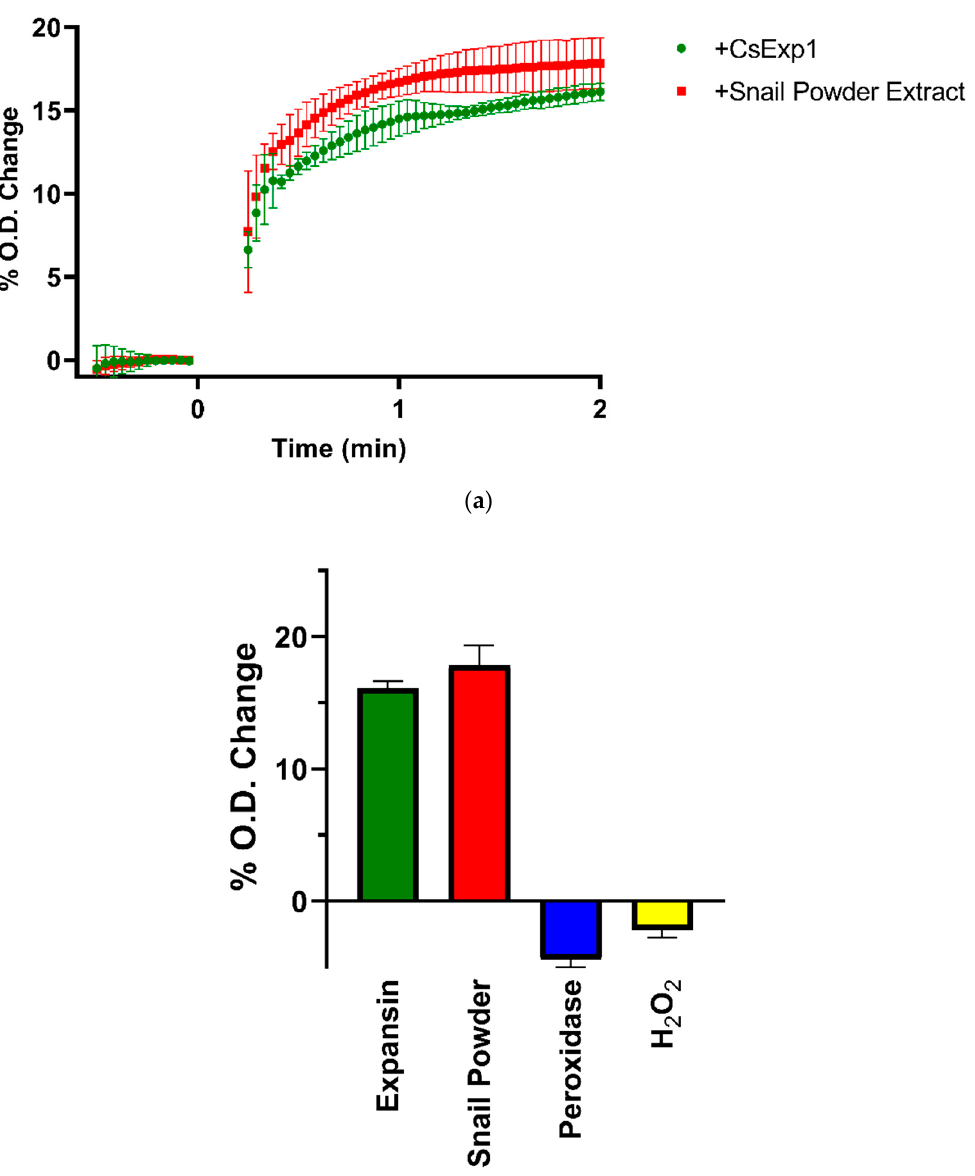
Figure 5. Effects of addition of 14 μ g CsExp1 expansin or 200 μ L snail powder extract on swelling of cell wall fragments from sunflower hypocotyls in suspension, measured by their effect on proportional O.D. at λ = 750 nm relative to initial O.D. ( a ) Time course of change in O.D. after addition at 0 s of expansin (green circles) or 200 μ L snail powder extract (red squares). ( b ) Summary of O.D. change 2 min after addition of expansin (green fill), snail powder extract (red fill), 2 units of horseradish peroxidase (blue fill), and H 2 O 2 to give a final concentration of 84 mM H 2 O 2 (yellow fill). Error bars indicate S.D. ( n = 3).